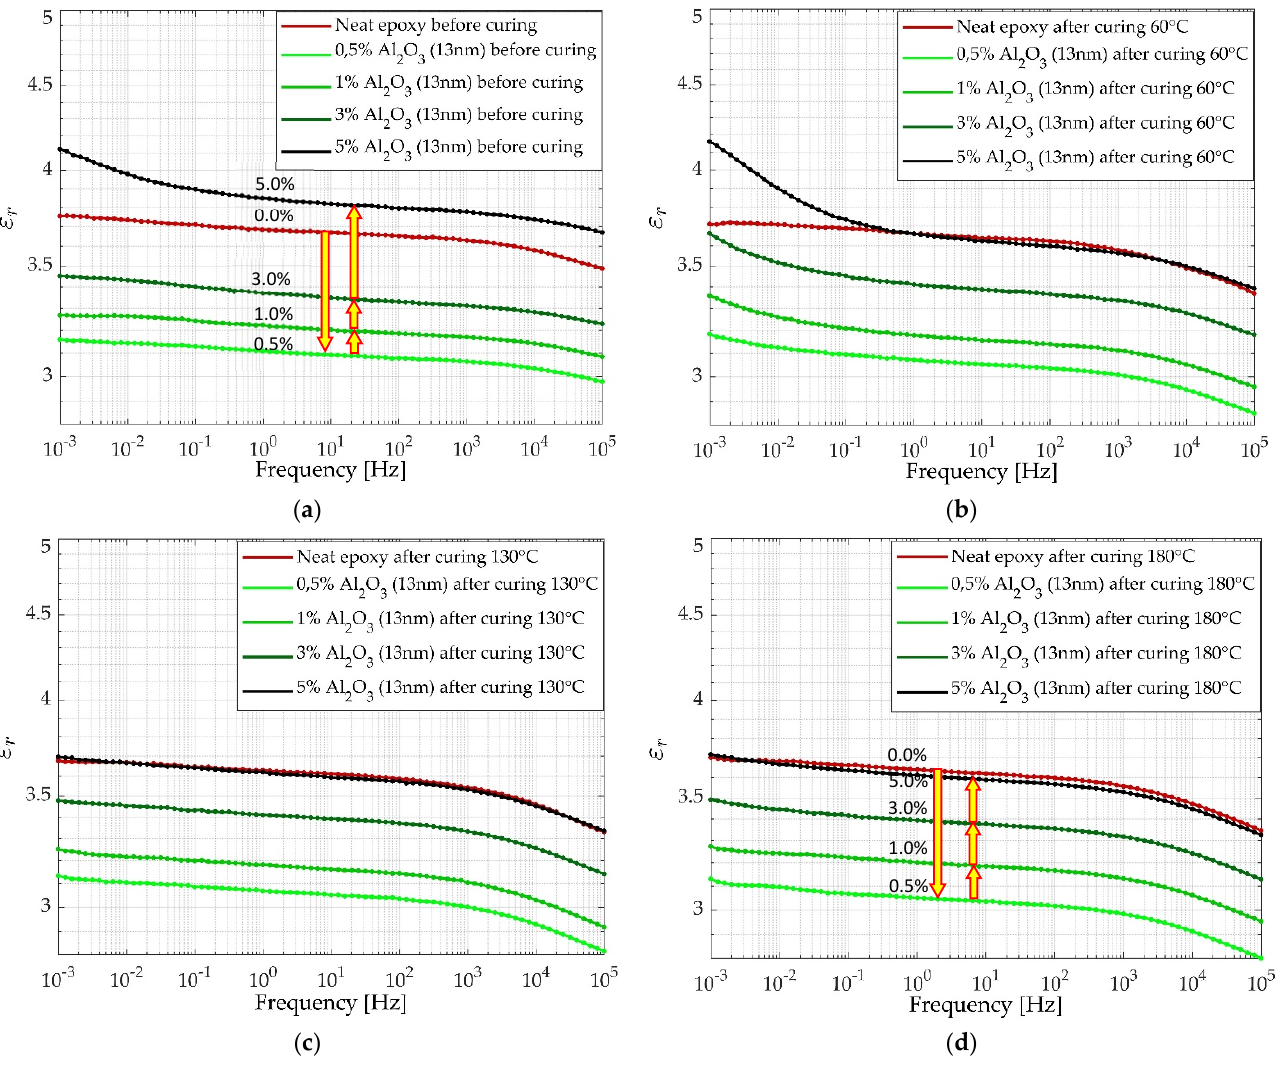
Figure 3. Broadband dielectric constant ε r ( f ) characteristics for samples with Al 2 O 3 , with particles of 13 nm: ( a ) new, before curing, ( b ) after thermal curing at 60 °C, ( c ) after thermal curing at 130 °C, ( d ) after thermal curing at 180 °C.